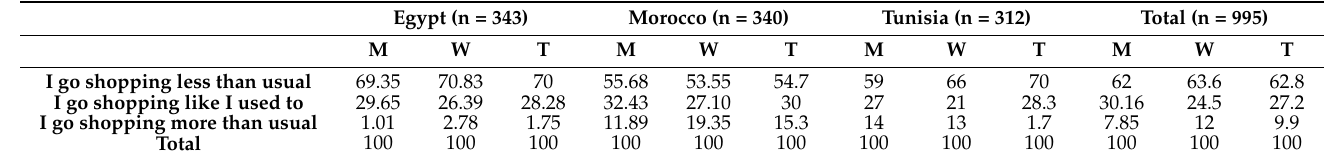
Table 4. Change in shopping behavior (percentage) (n = 995).